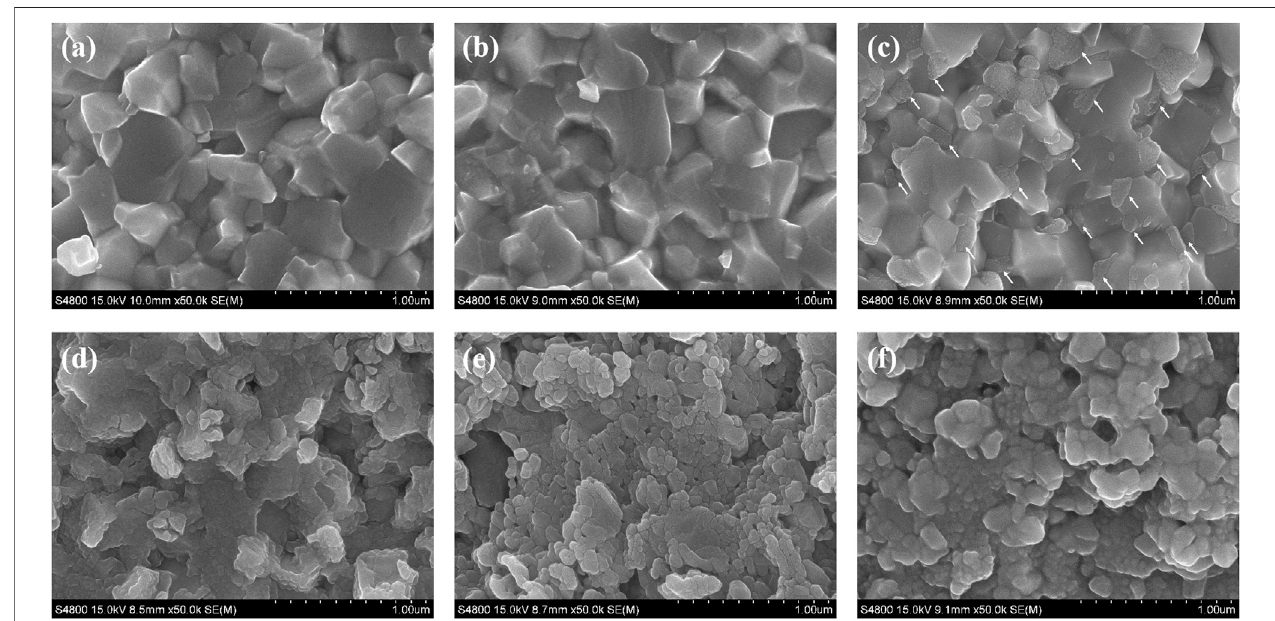
FIGURE7| SEM images ofthe fracture surfaceofWC-1wt.% Y 2 O 3 oxidized at differenttemperatures. (A) original; (B) 300 ° C; (C) 350 ° C; (D) 400 ° C; (E) 500 ° C; (F) 600 ° C.